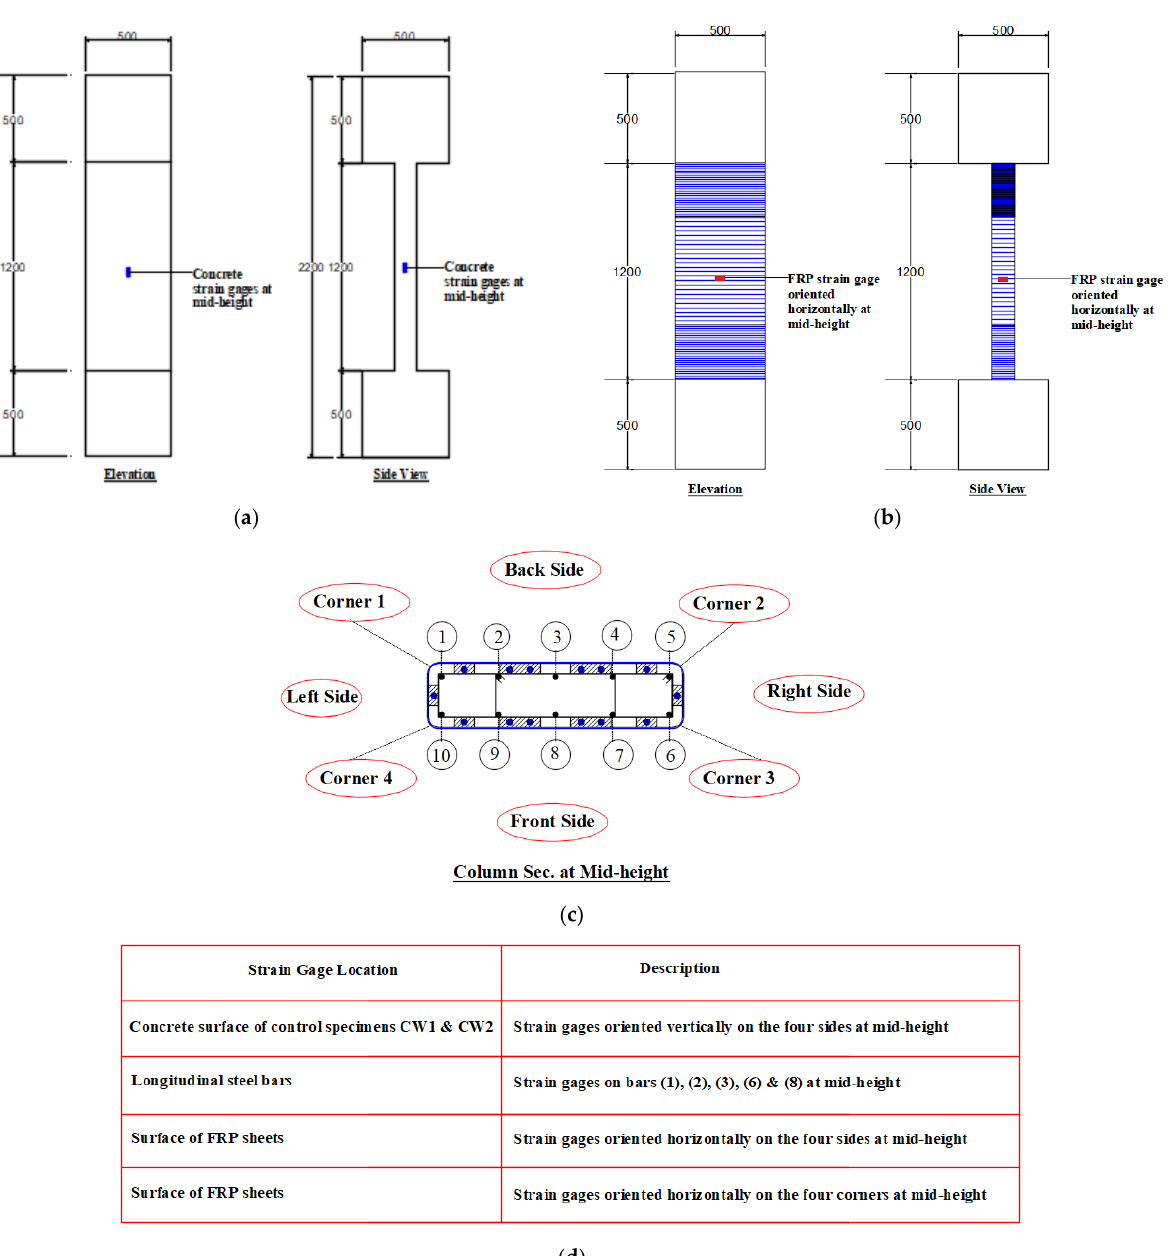
Figure 8. Layout of strain gages for test specimens (note: all dimensions are in mm): ( a ) locations on concrete surface for control specimens CW1 and CW2; ( b ) locations on FRP surface for strengthened specimens; ( c ) numbering of steel rebars for all specimens; and ( d ) table showing locations for different parts of test specimens.